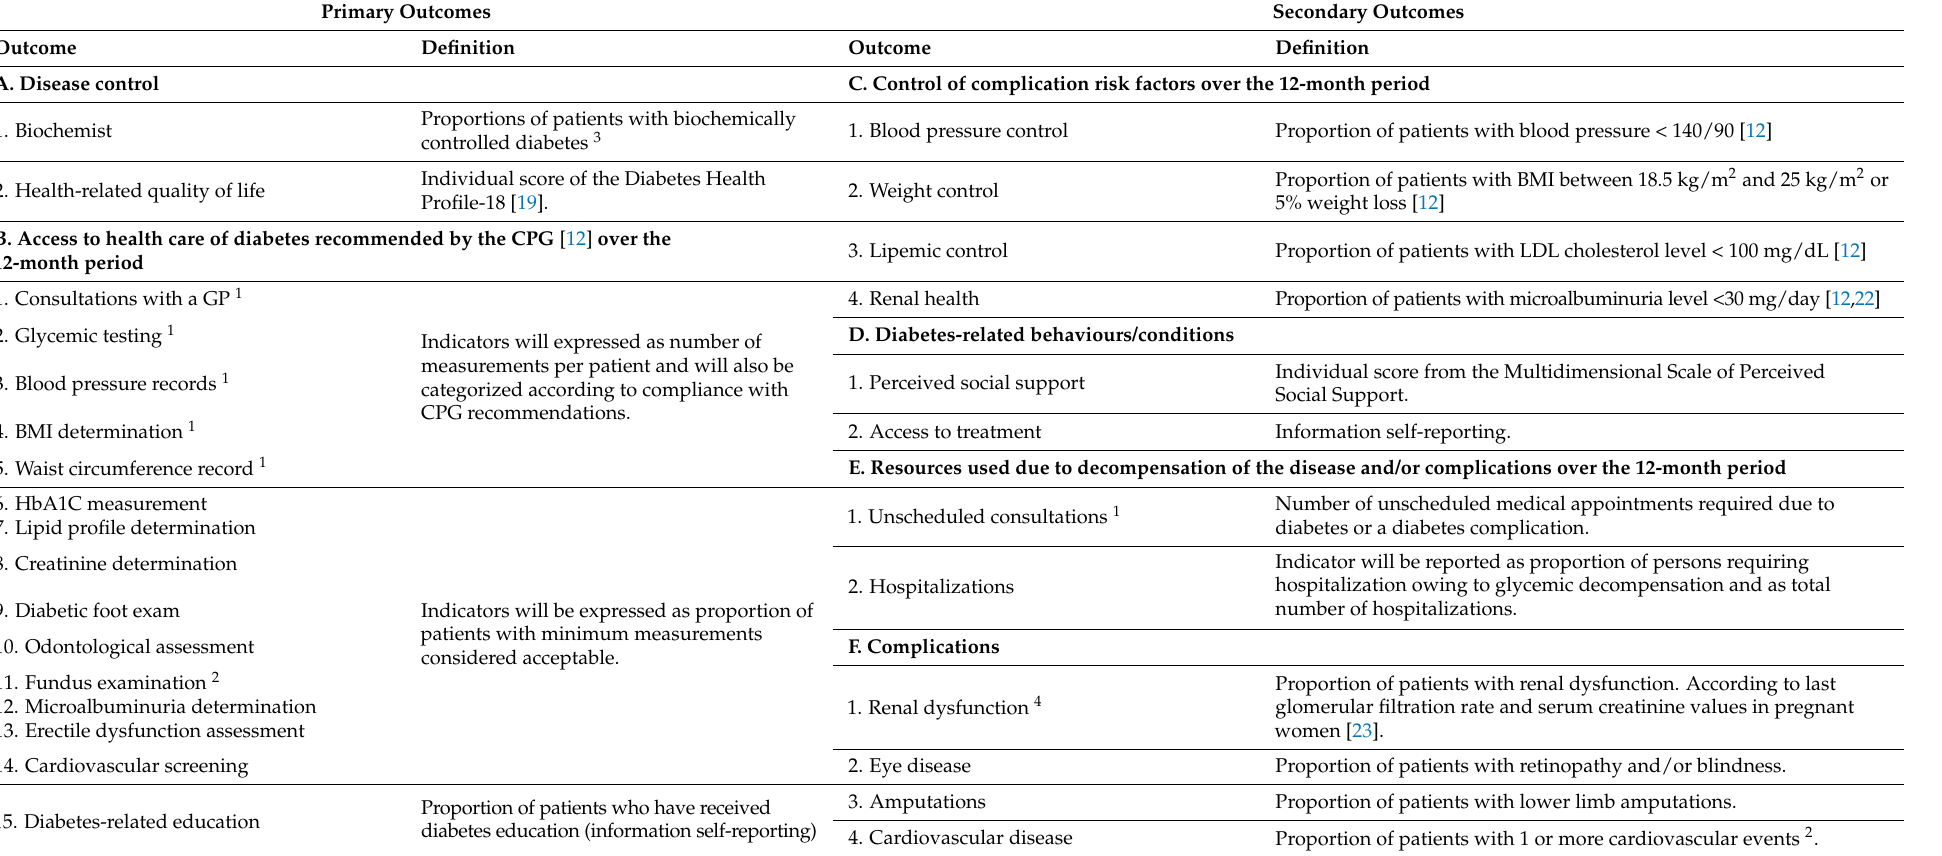
Table 2. Study outcome